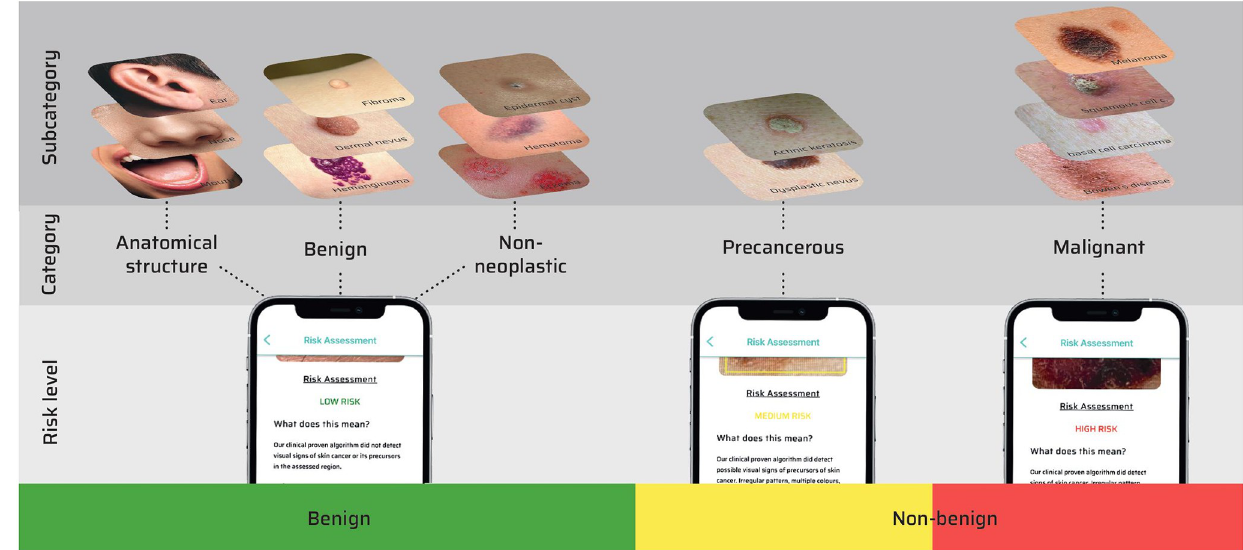
Fig 1. Graphical depiction of the "three-level